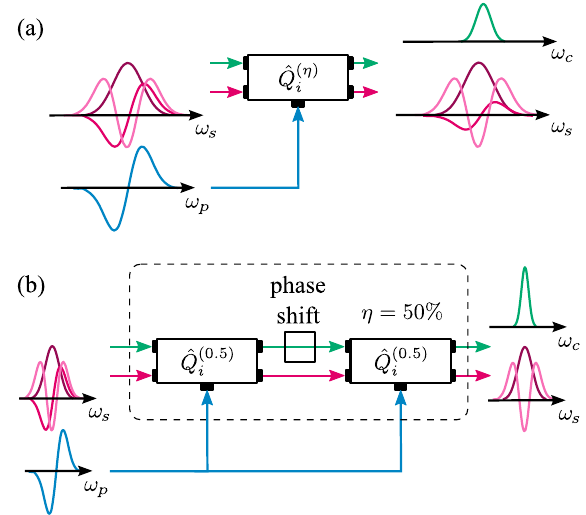
FIG. 5. (a) Schematic of the QPG operation. The shape of the blue pump pulse selects one TM from the “ red ” input signal and converts it to the “ green ” output with an efficiency of η . All other signal TMs are completely transmitted. The index i labels the addressed input TM. (b) A Mach-Zehnder – or Ramsey-like configuration of two successive QPGs with an efficiency of 50% each overcomes the time-ordering limitations of a single QPG and facilitates the selection and conversion of a single TM with an efficiency of